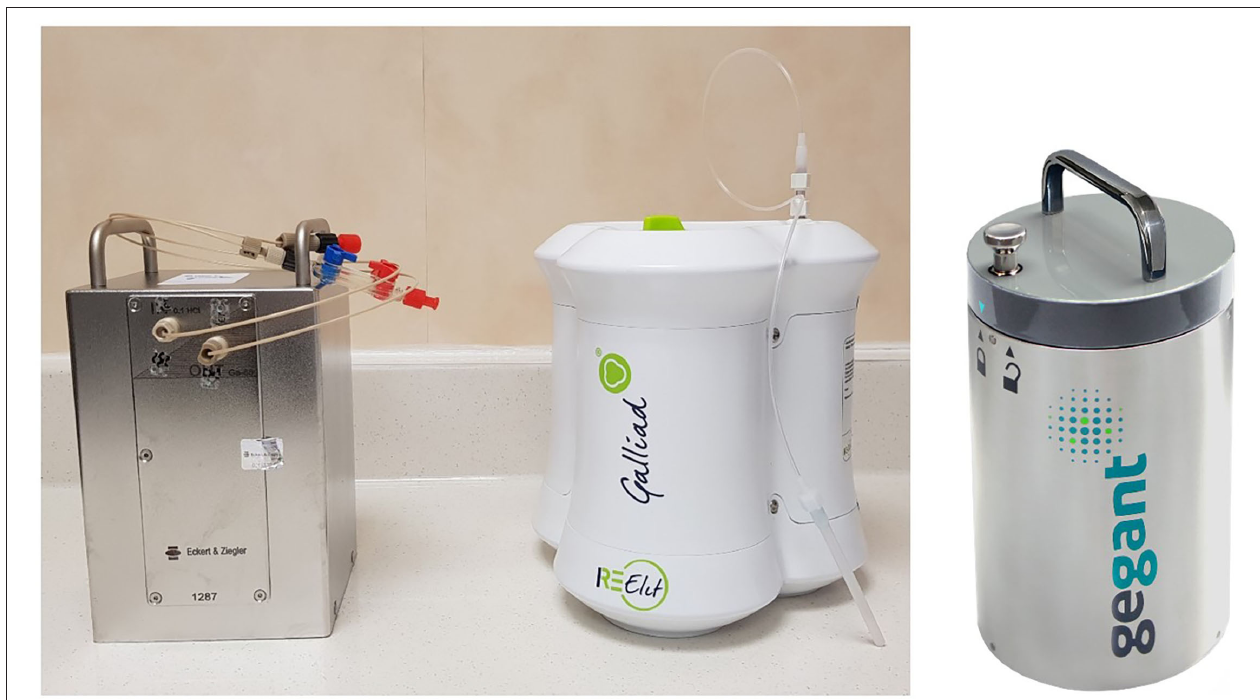
FIGURE 1 | Radiopharmaceutical grade germanium-68 ( 68 Ge)/gallium-68 ( 68 Ga) generators from left to right: Galliapharm ® , Galli Ad ® , and GeGant ®